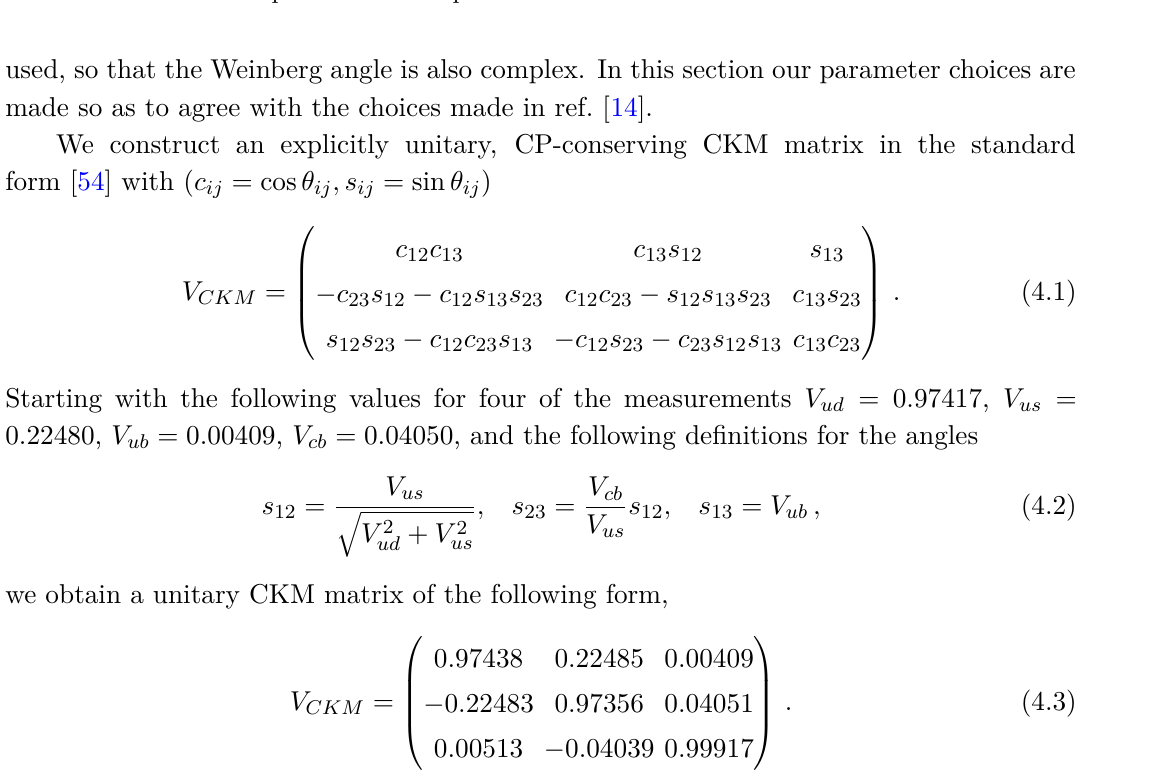
Table 2 . Input and derived parameters used for our numerical